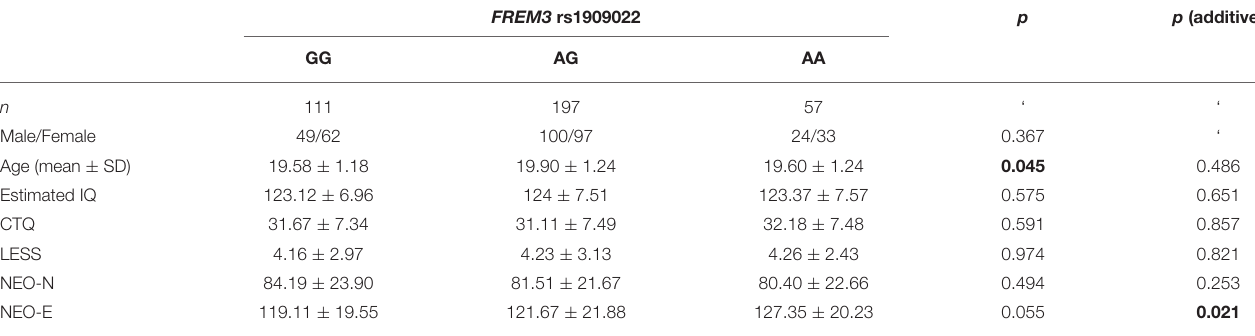
TABLE 2 | Summary of demographic characteristics and estimated IQ represented as a function of FREM3 rs1909022 genotype.